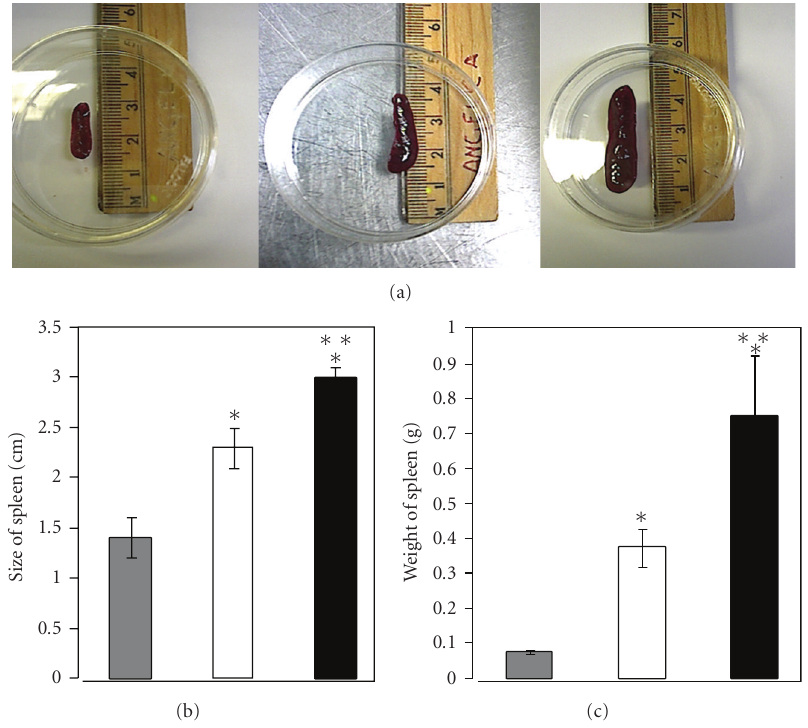
Figure 2: Spleen changes of mice infected with T. cruzi strains. Groups of three mice were inoculated with PBS (grey bar) or 1 × 10 5 T. cruzi BT of Ninoa (white bar) or Qro (black bar) strains and spleens were obtained at acute phase of infection. (a) Growth of spleen from mice infected with Ninoa (center) and Qro (right) strains compared with control non infected mice (left). Size (b) and Weight (c) of spleen from mice infected. Media value and standard deviation are shown. Statistical di ff erences ( P < . 001) were determined between control and infected mice ( ∗ ) and between Ninoa and Qro strains ( ∗∗ ) by ANOVA Bonferroni post-test. Table 1: Immunoglobulin isotype and kinetics of antigen recognized in mice infected with T. cruzi I strains. Strain Isotype Antigens recognized